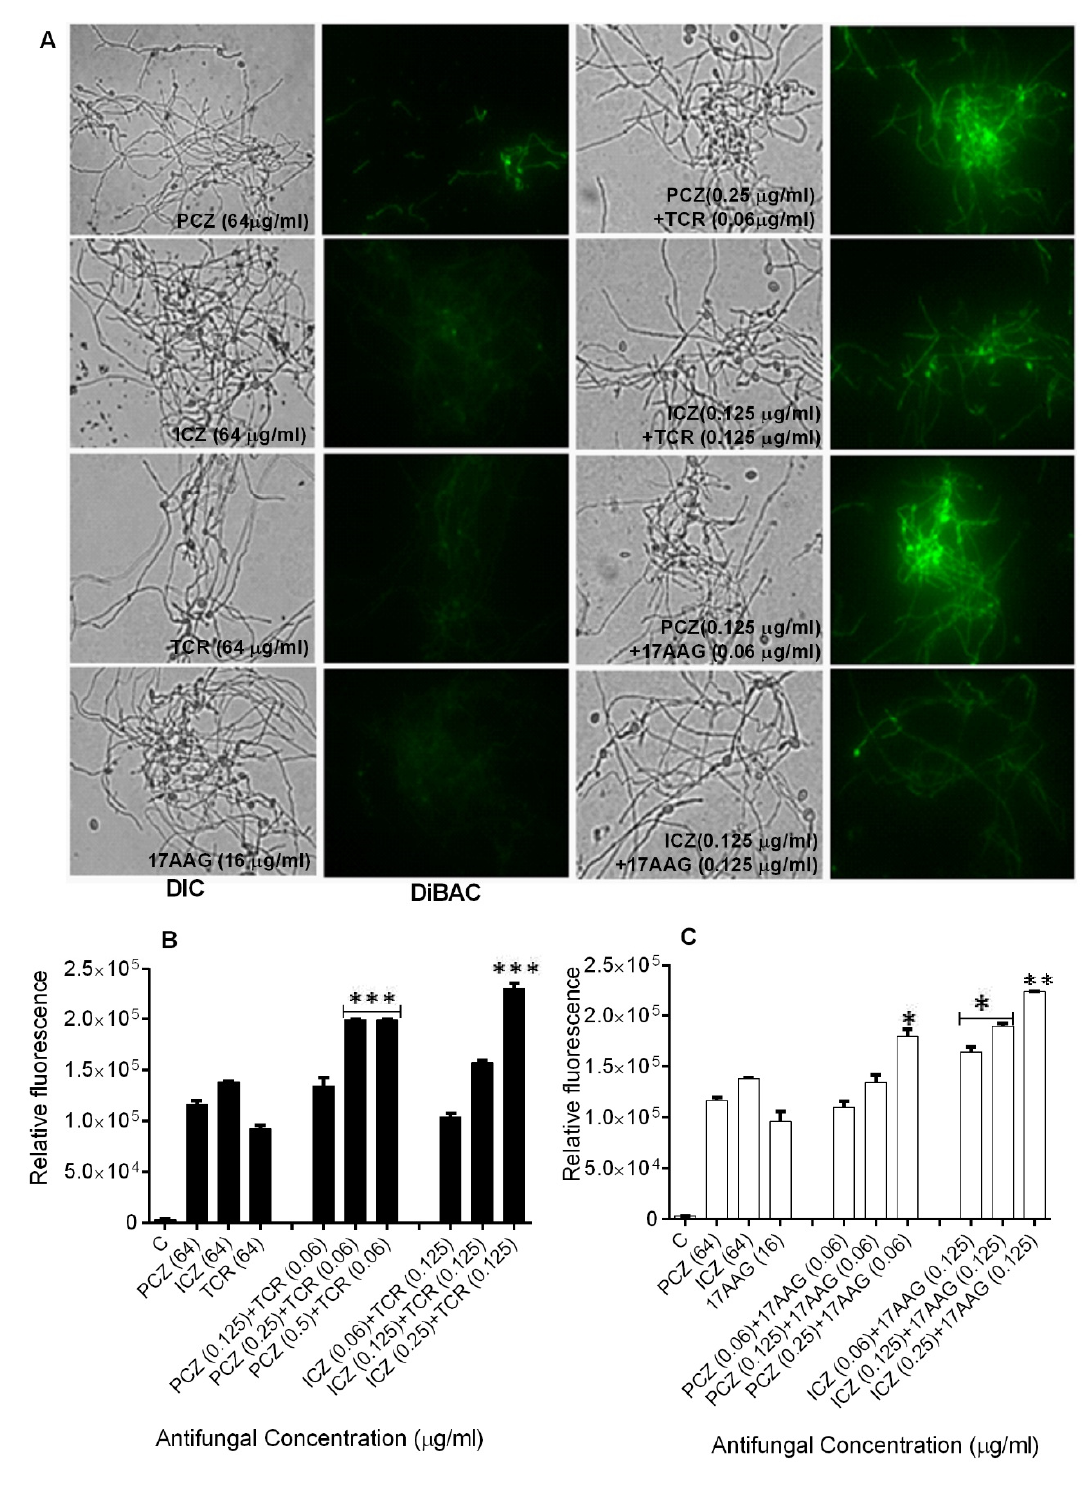
FIGURE 1: Fungicidal action of PCZ and ICZ alone and in combination with TCR and 17AAG against S. prolificans germlings (isolate 1). (A) Fluorescent images of S. prolificans germlings stained with the morbidity dye DiBAC. (B, C) Relative fluorescence levels in S. prolificans germlings treated with PCZ or ICZ plus TCR (B) or 17AAG (C) as determined using DiBAC staining. The experiments were performed in tripli- cate and repeated three times. *p<0.05; **p<0.001; ***p<0.0001 (compared with untreated control germlings and germlings exposed to drug alone). Error bars on graphs indicate standard deviation. DIC, differential interference